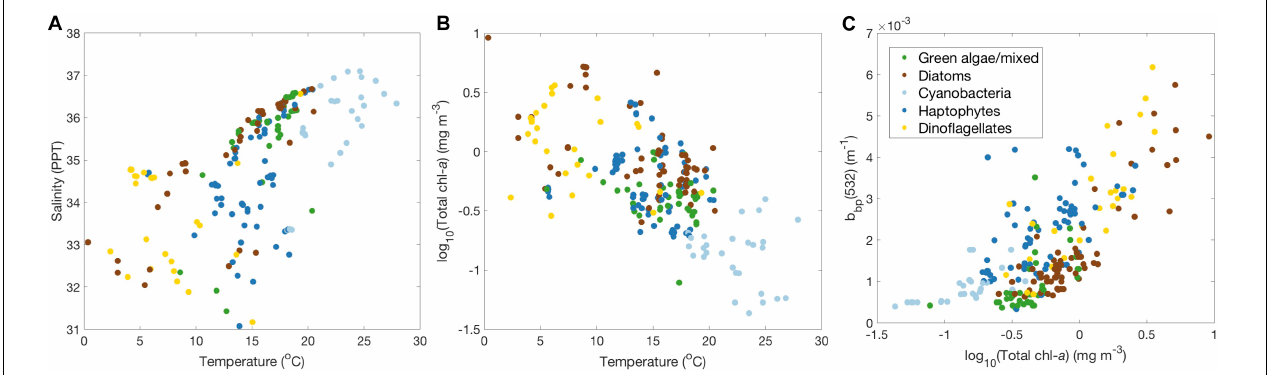
FIGURE 10 | Regressions of physical and environmental parameters including (A) salinity vs. temperature, (B) total chlorophyll- a vs. temperature, and (C) particle backscattering (b bp ) at 532 nm vs. total chlorophyll- a , all colored by the dominant community (light blue = cyanobacteria, dark blue = haptophytes, green = green algae, brown = diatoms, gold = dinoflagellates). to varying pigment contributions across taxa and time